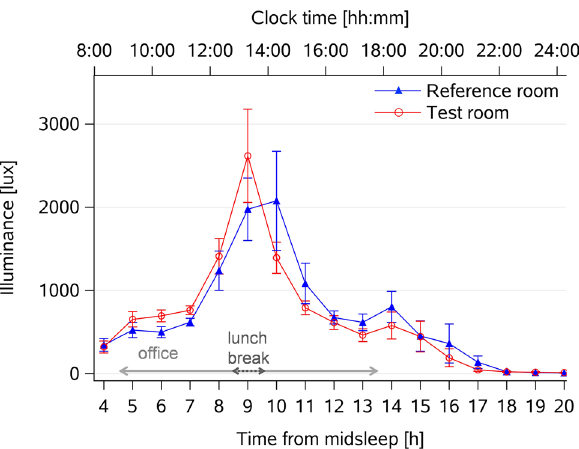
Figure 2. Individual light exposure (E v ) from wearable light sensor devices across the entire waking period. Time course of averaged individual illuminance (E v ) from wearable light sensors recorded across the entire waking period, averaged across 5 days (mean values ± SEM; Test room = red lines and circles, n = 30; Reference room = blue lines and triangles, n = 33). The x-axis at the bottom shows elapsed time since habitual midsleep (h), and the upper x-axis depicts corresponding clock times. The horizontal arrows show the time in the offices (light grey arrow) and the lunch break (spent outside the office; dotted grey